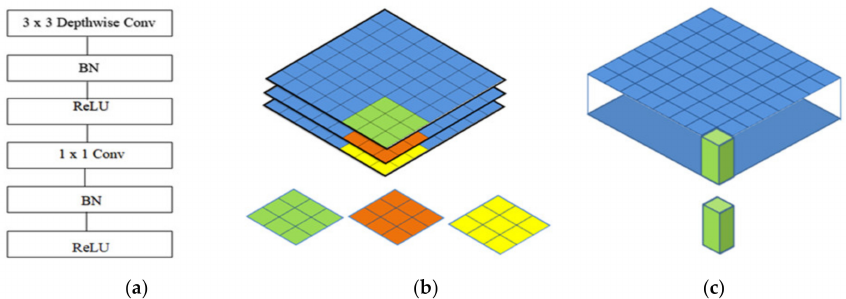
Figure 3. The architecture of MobileNet: ( a ) the convolutional layers of MobileNet; ( b ) the depth-wise convolution kernel; ( c ) the pointwise convolution